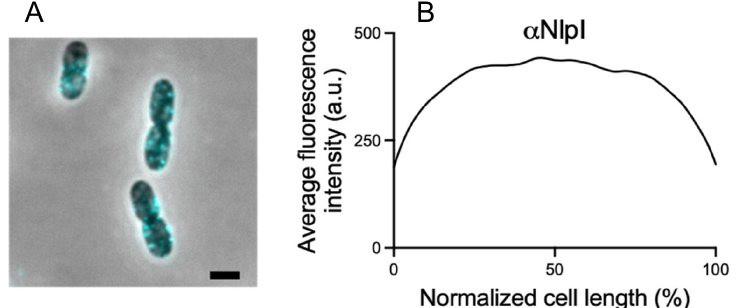
Figure 4. E. coli wild type cells immunolabelled against NlpI. Microscopy images ( A ) and fluorescence average profile ( B ) show no evident midcell localization for the NlpI lipoprotein. LMC500 wild type cells were grown to steady state in minimal medium at 28 ° C. (n = 1015). Scale bar is equal to 1 μ m.